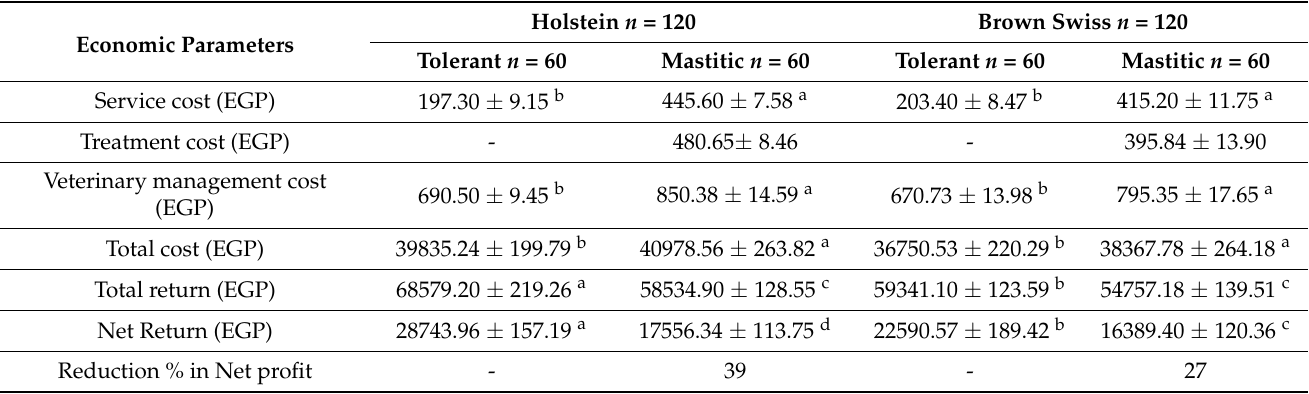
Table 4. Service cost, treatment cost, total veterinary management cost, total cost, total return, net return and reduction in net profit percentage per cow in Holstein and Brown Swiss